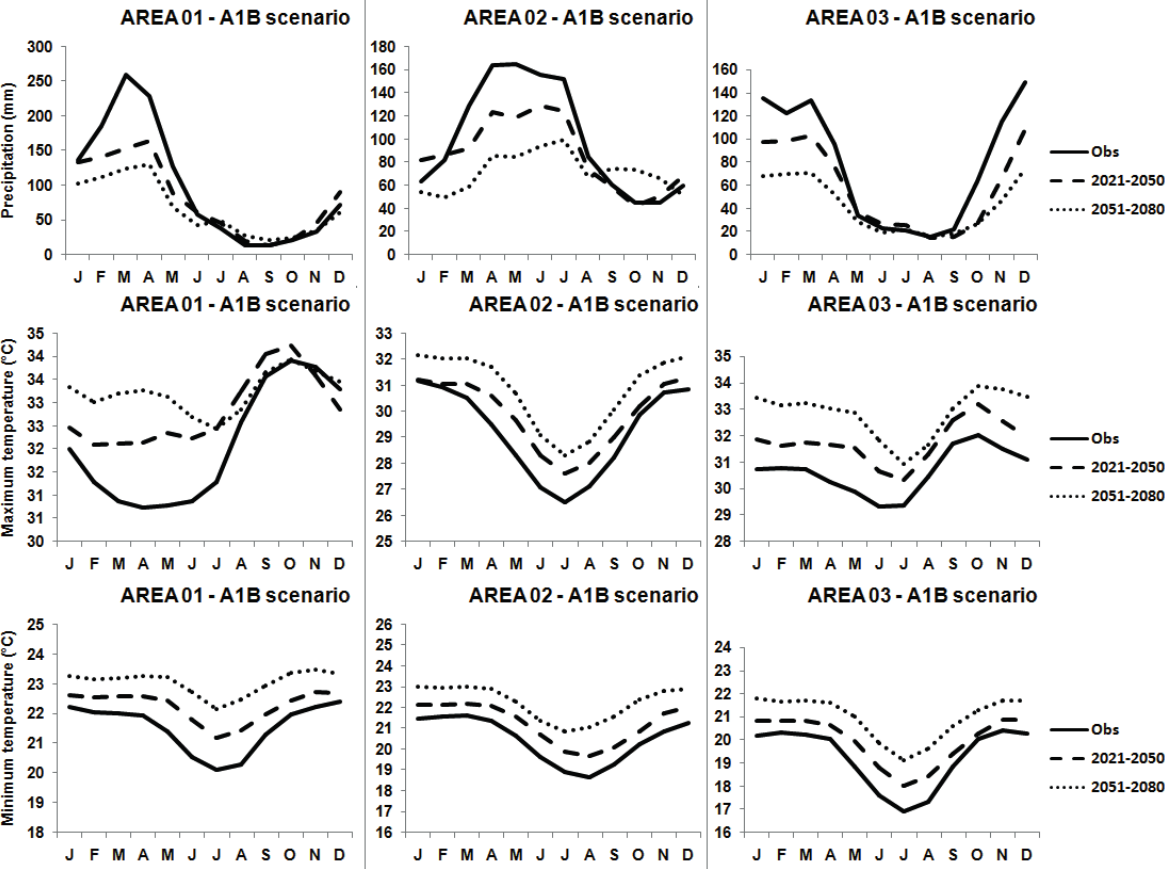
Figure 5. here top row Observed annual cycle of rainfall (Obs, 1961-1990) and projected future changes for the three areas over the two periods of time (2021-2050 and 2051-2080), middle row The same as in the top row , but for monthly averaged for maximum temperature, bottom row The same as in the top row, but for monthly averaged minimum